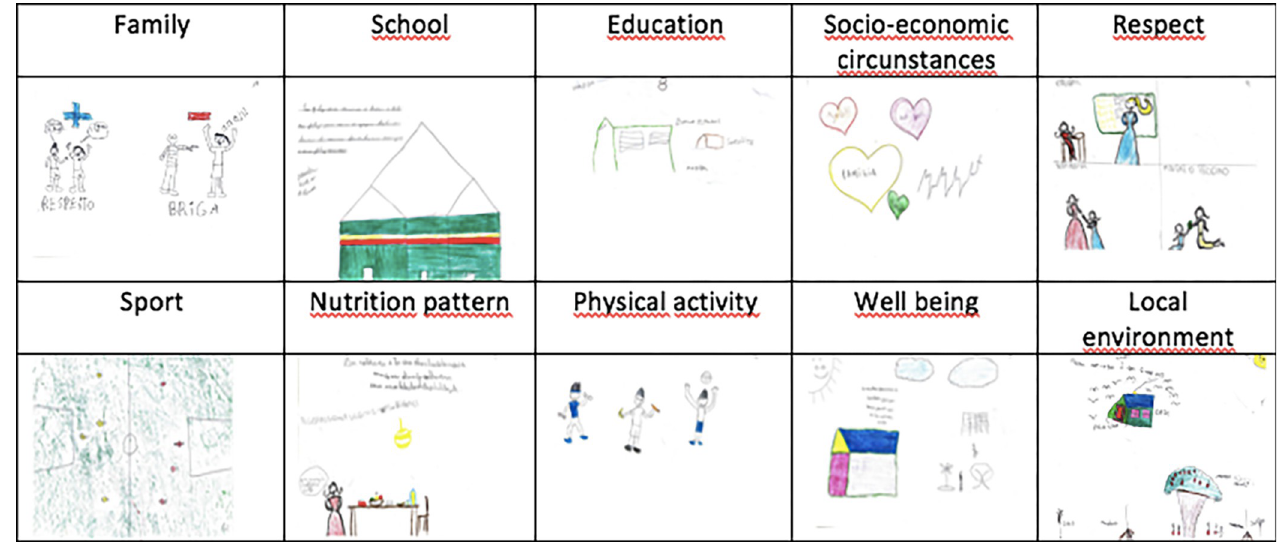
Fig 2. Drawing examples from 9–11 years old students associated to each theme and based on their perspectives in response to the prompt ‘To be happy it is necessary to ... ’ And “To have a healthy body it is necessary to ... ” .